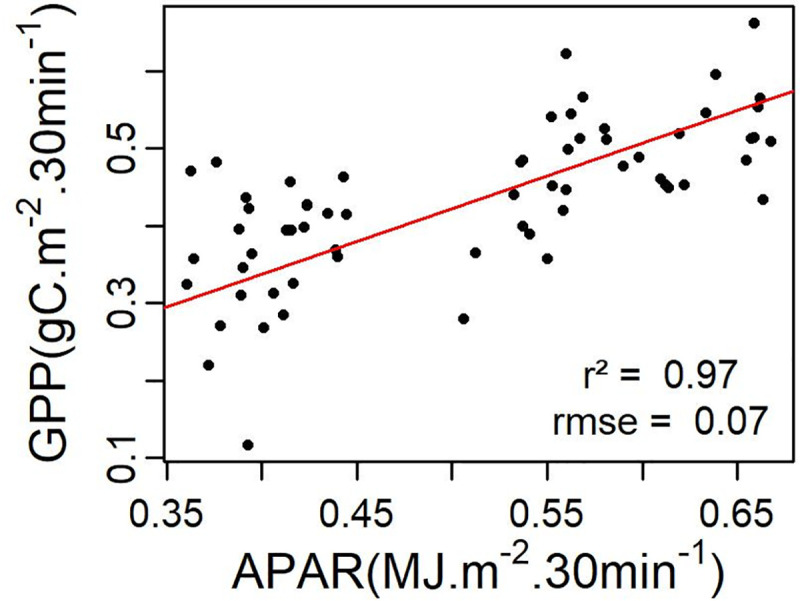
Relationship between half-hourly GPP and APAR.The red line is the linear regression line through origin fitted to the cloud of points (black dots), representing midday data for uncloudy days during the growing season. The resulting equation is: GPP = 0.85 *APAR.